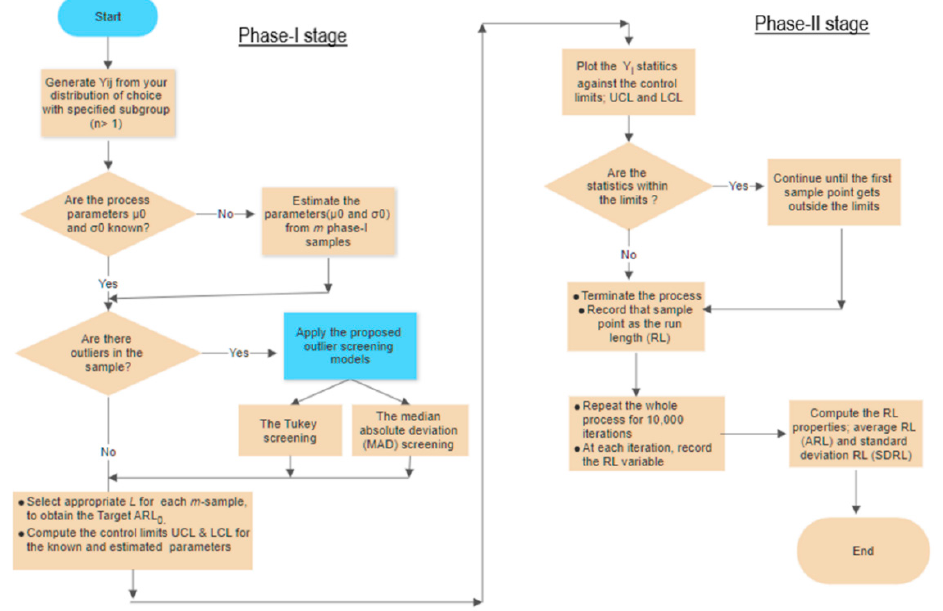
Figure 1. Flowchart of the procedures of proposed Shewhart control chart.